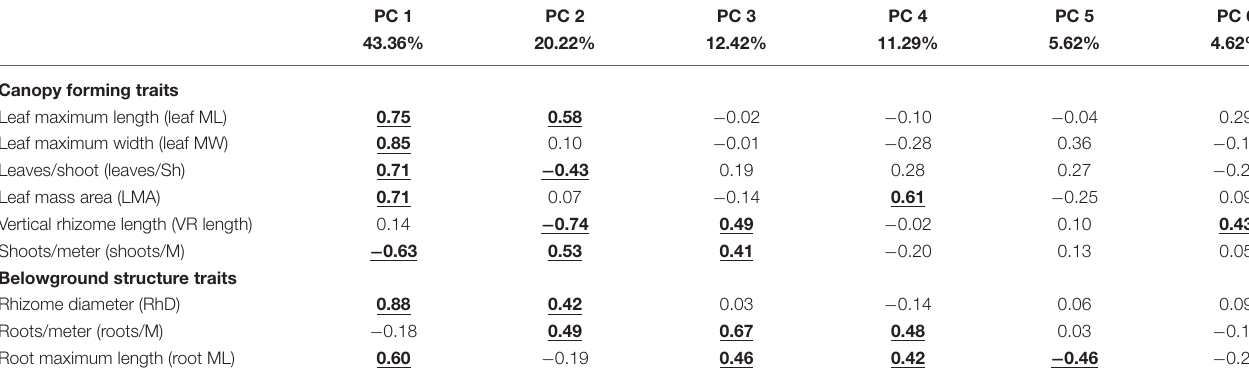
TABLE 5 | Correlations of the functional traits to the dimensions of the multidimensional space ( Figure 6 ).